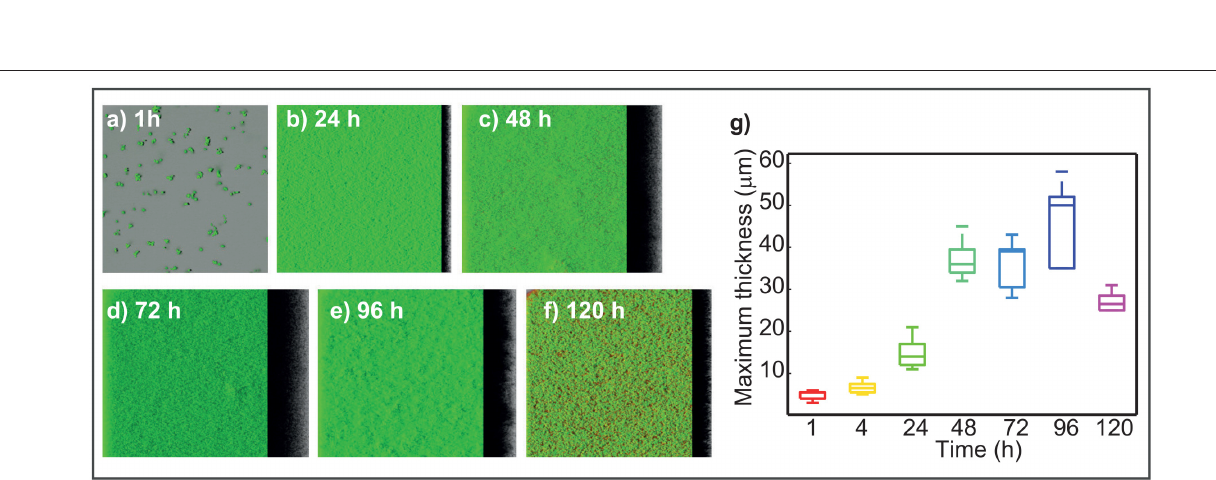
Frontiers in Microbiology |